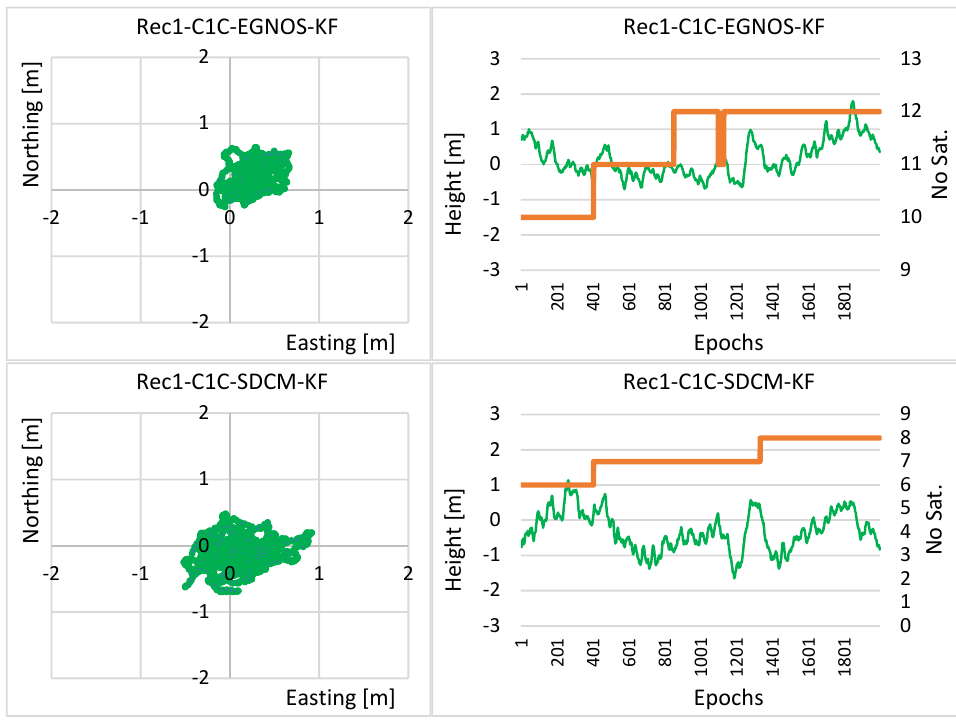
Figure 9. Real errors of horizontal and vertical coordinates of SBAS positioning based on C1C code, for the receiver Rec1 with EGNOS or SDCM corrections, with the use of Kalman filtering (Step III, see Figure 1).